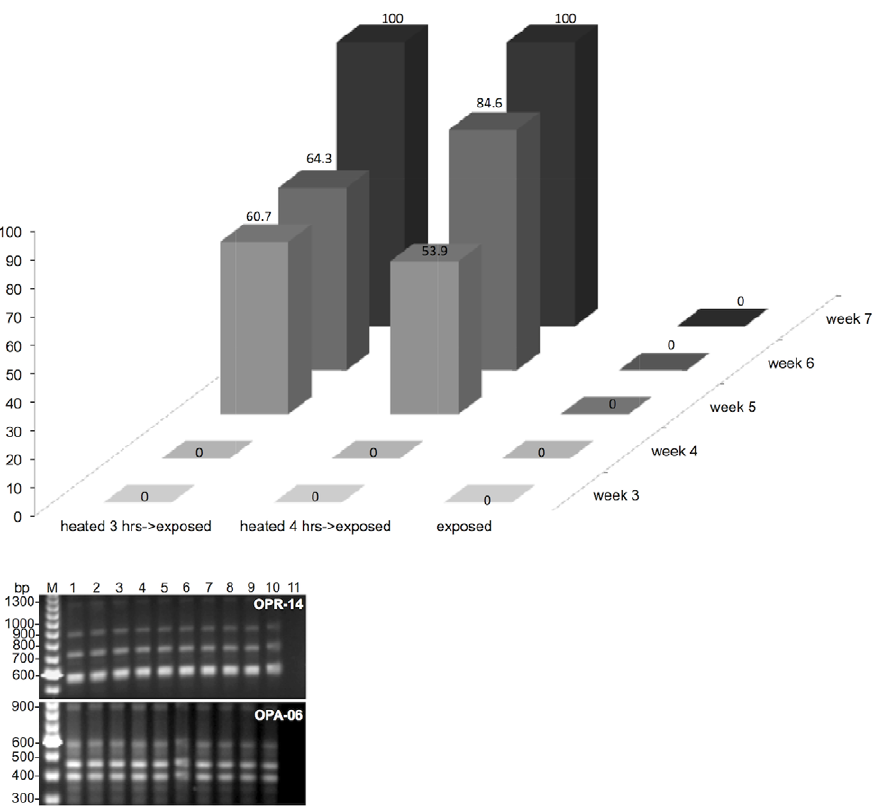
Figure 3. Genotyping of adult S.mansoni parasites generated from cercariae released from resistant BS-90 snails following the combination of heat-pulse and parasite infection. ( A ) Percentage of BS-90 resistant snails shedding cercariae after 7 weeks parasite exposure. Note that snails that were exposed to S. mansoni without being subjected to the heat-pulse treatment, as expected, remained negative (0) whilst those kept for either 3 hrs or 4 hrs prior to exposure began shedding cercariae at 5 weeks PE. ( B ) RAPD-PCR genotyping of the genomic DNA from individual (lanes 1–7) male worms harvested from mice infected with cercariae released from BS-90 ‘resistant’ snails. Note that the DNA profiles of these parasites, generated with two different random primers, OPR-14 and OPA-06, were invariant when compared to profiles generated with the same primers but with DNA from individual (lanes 8–10) worms harvested from mice that were infected with cercariae shed from susceptible (NMRI) snails. The negative control, i.e. amplification without DNA template is shown in lane 11 and the lane labeled M shows position of 100 bp ladder, run in parallel as standard.